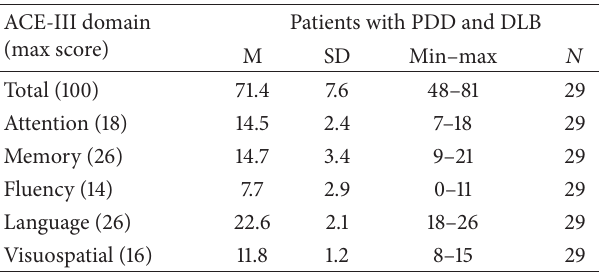
Table 1: Mean performance on ACE-III domain